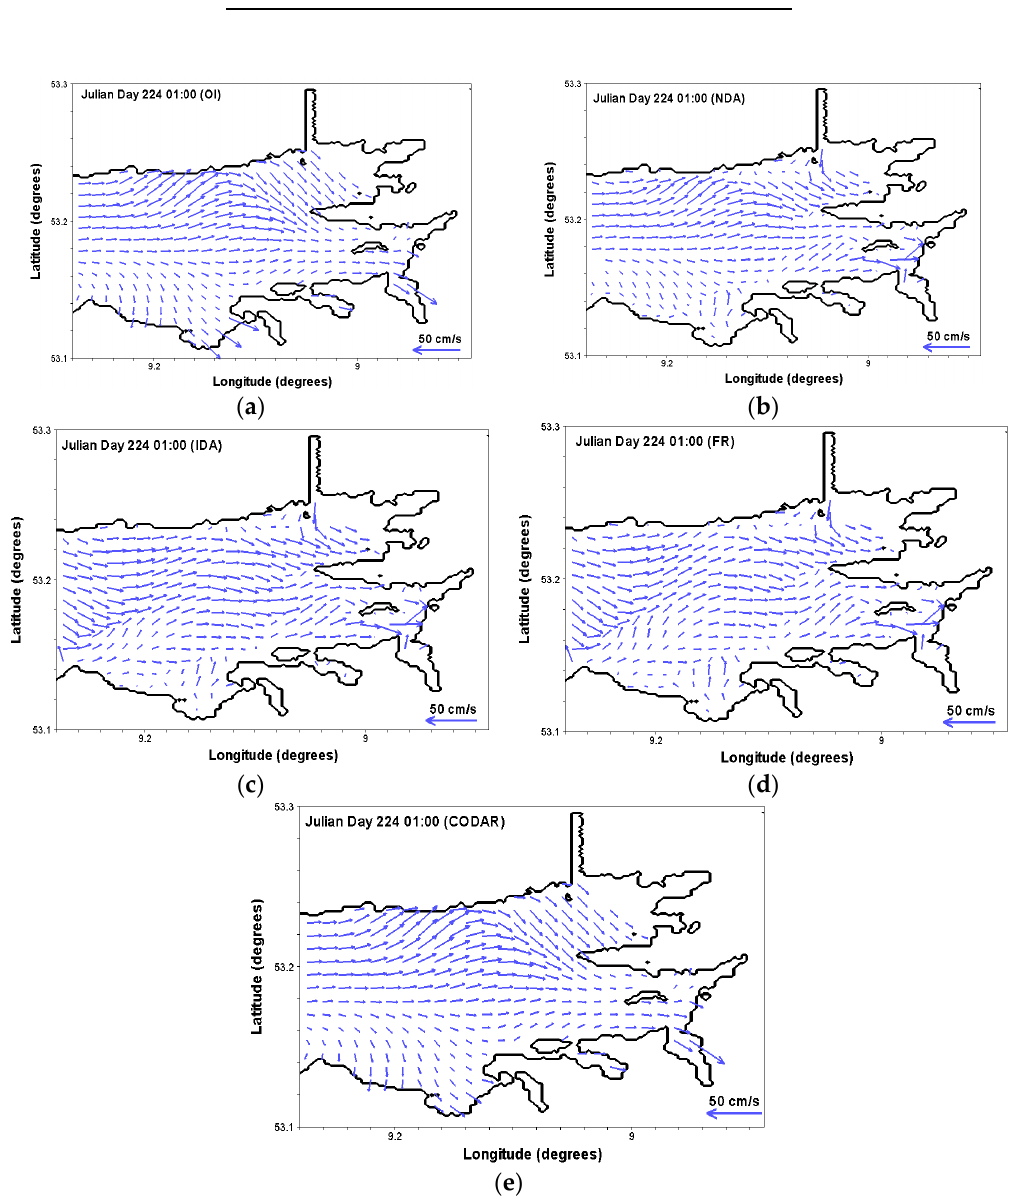
Figure 4. Vector fields of surface currents during hindcasting (Julian Day 224 01:00): ( a – c ) model OI, NDA and IDA, respectively; ( d ) model FR; and ( e ) HFR data.